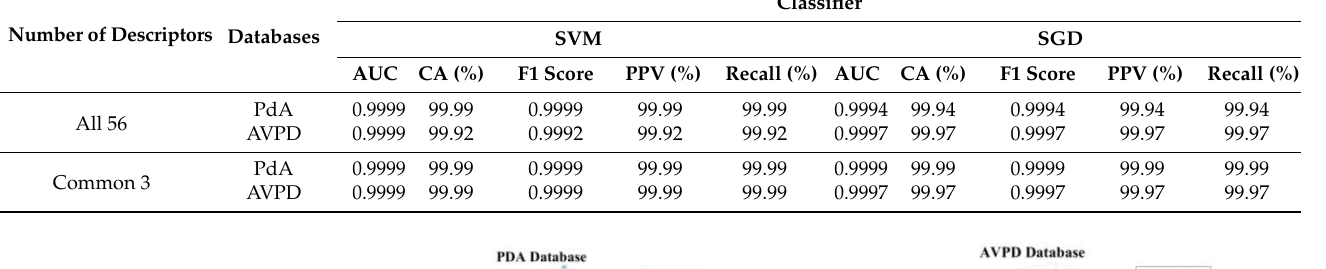
Table 12. Classifier performance measures for voice pathology identification for PdA and AVPD.